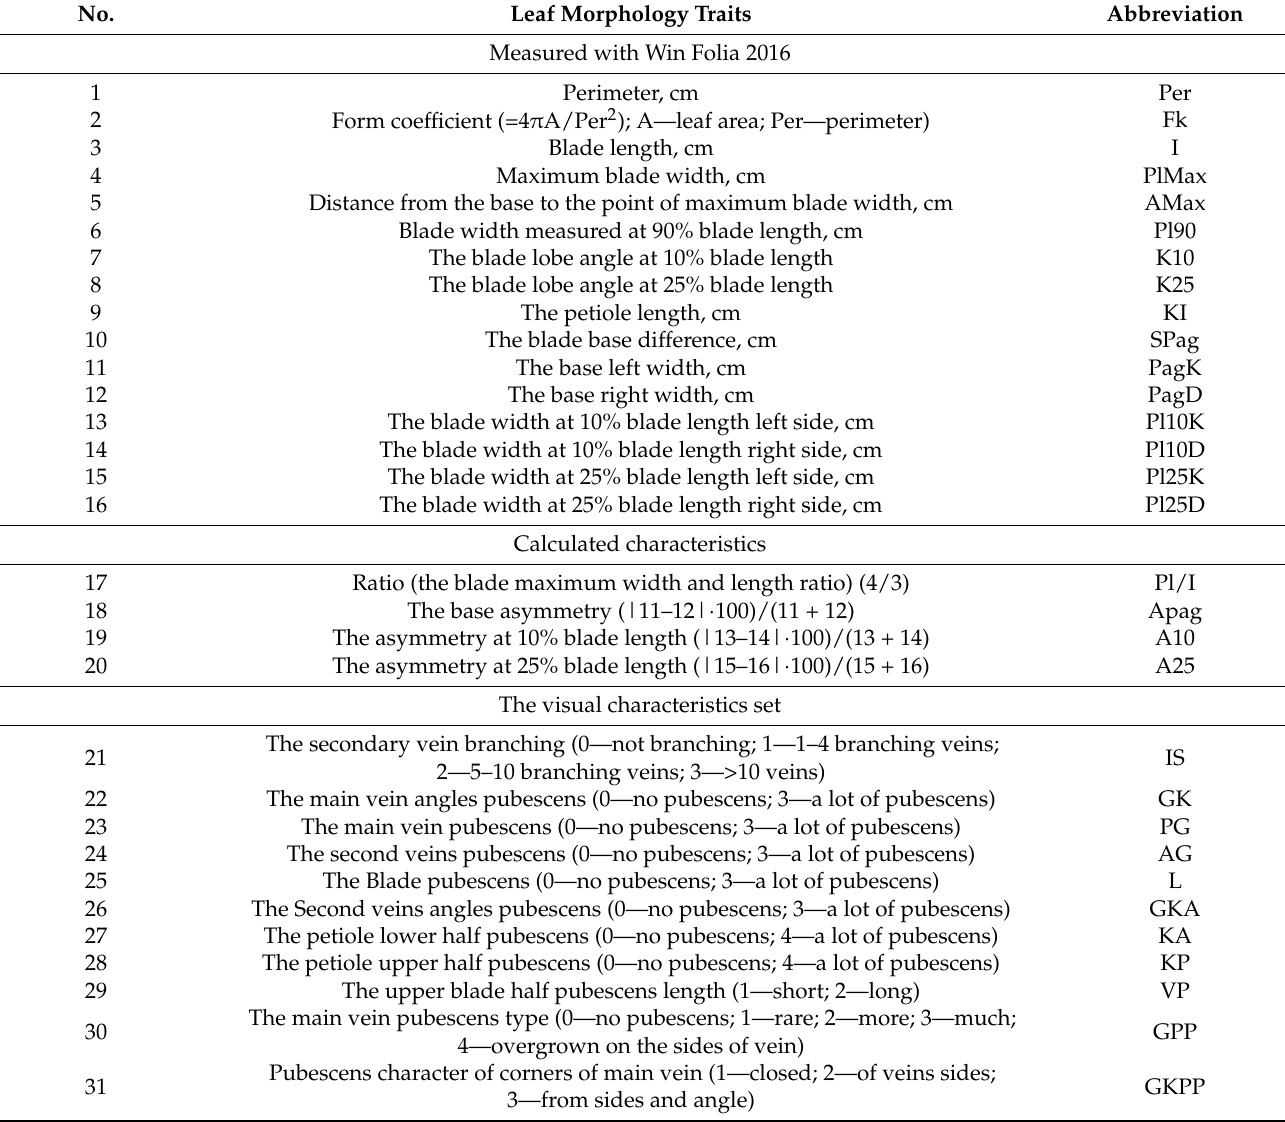
Table 1. The leaf morphology traits of elm species. No. is a trait ID for referencing in the text.